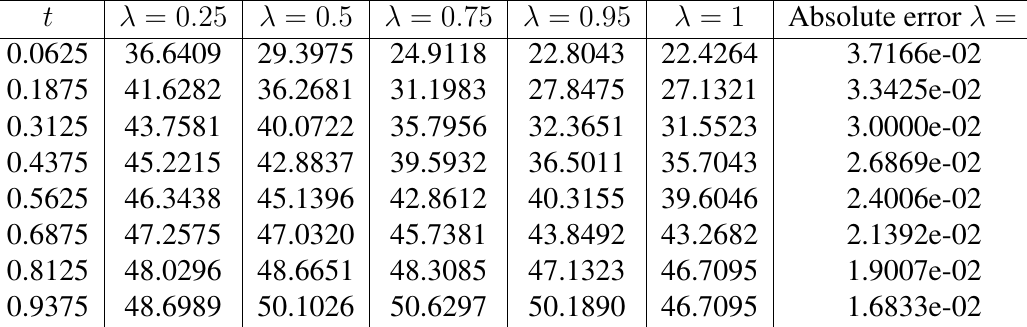
Table 4: The achieved absolute errors and numerical solutions of Example 4.4 using the proposed strategy for J = 2 and T = 1